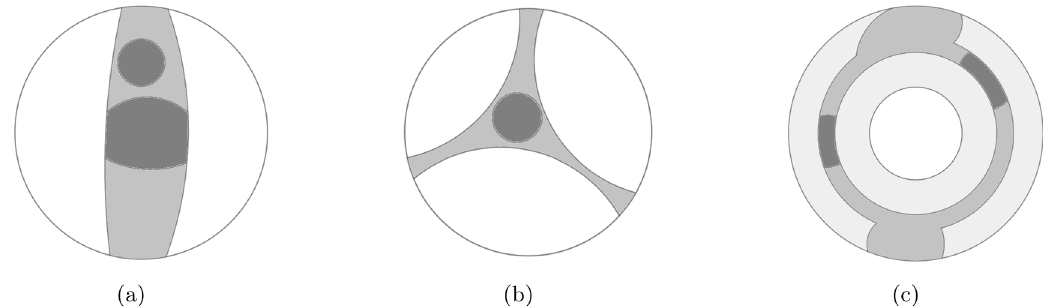
Figure 1: Three cases satisfying the condition ( I 1 )